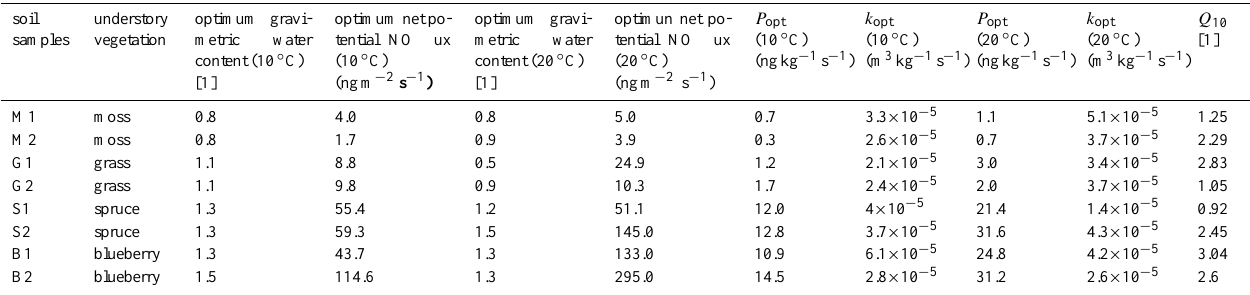
Table 2. Net potential NO flux (in terms of mass of nitrogen) calculated with the diffusion coefficient according to Millington and Quirk (1960); NO production rates (P opt ) and the NO consumption coefficients (k opt ) are calculated for 10 ◦ C and 20 ◦ C and the Q 10 values. All values are at optimum gravimetric soil moisture ( θ opt